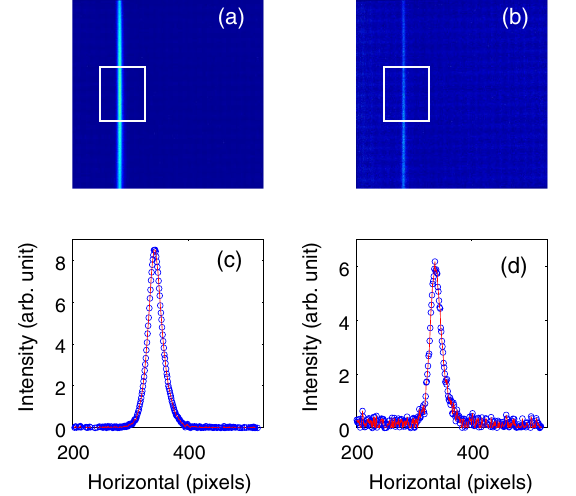
FIG. 8. OTR images of vertical stripes (a) total OTR and (b) vertically polarized OTR. The projected x profiles from the region of interest are shown below each image.